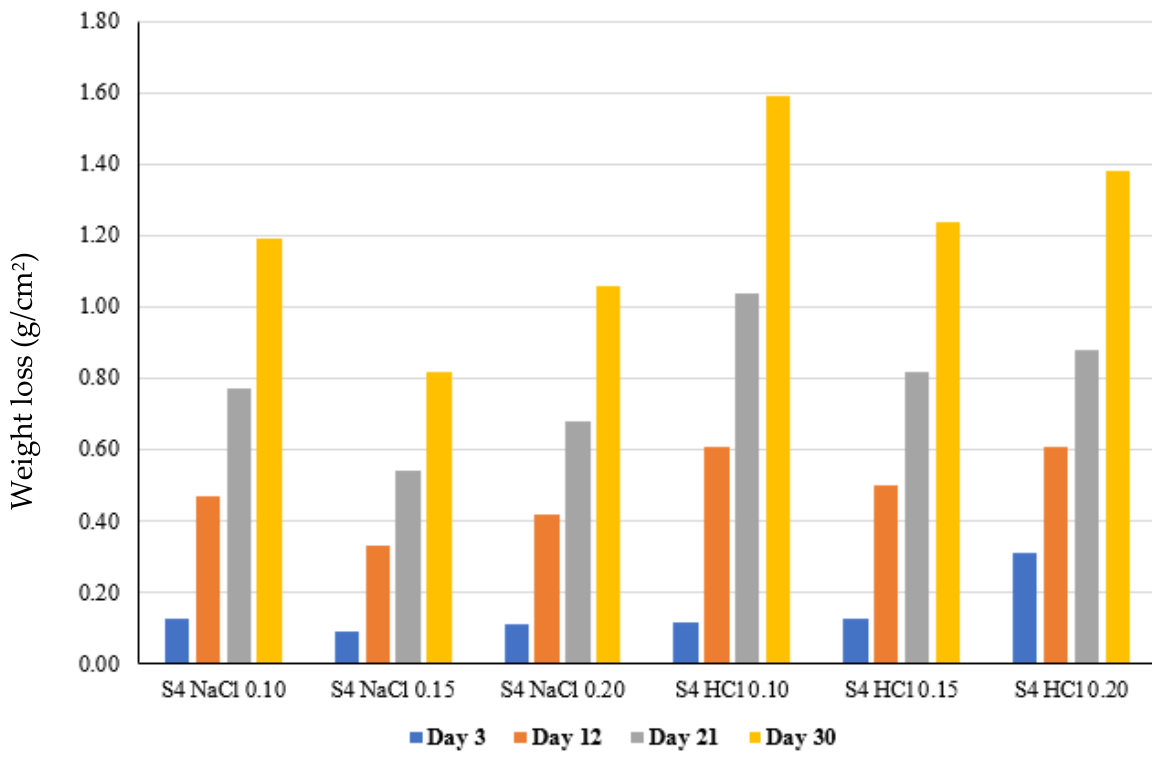
Figure 4. Effect of CaCO 3 on corrosion behaviour of S 4 (2%).